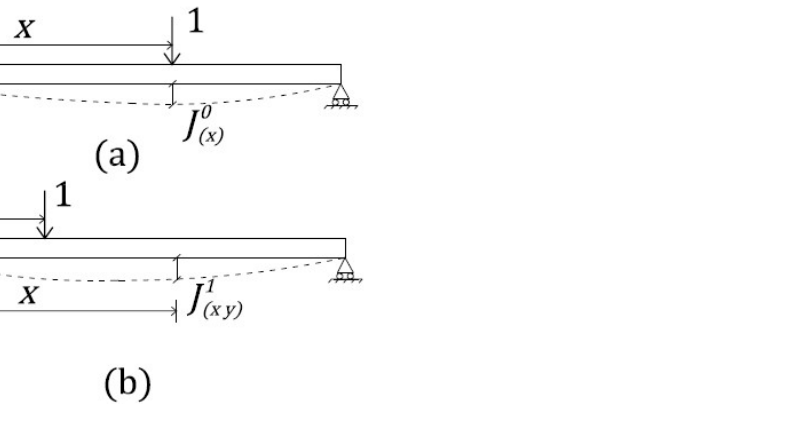
Figure 5. Deflection responses to moving unit load: ( a ) Response at x to load at x ; ( b ) Response at x to load at y.